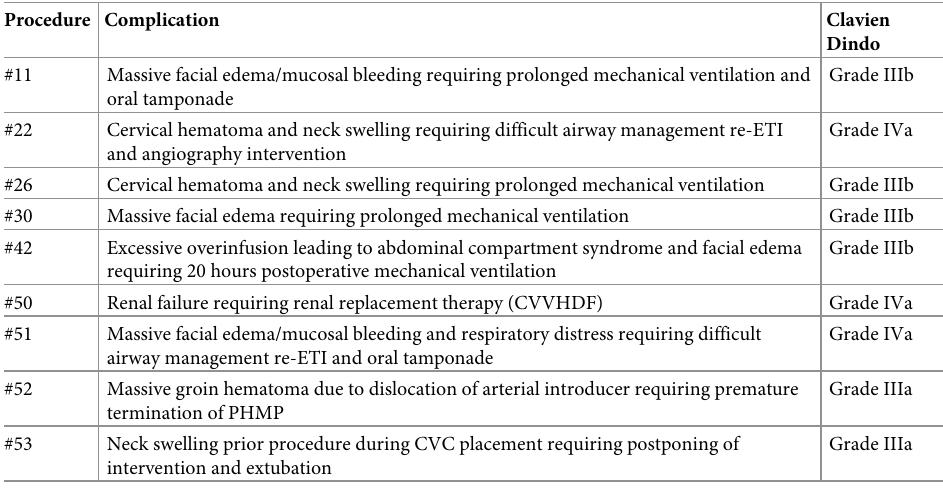
Table 3. Severe perioperative complications and adverse events until intensive care unit discharge. Procedure